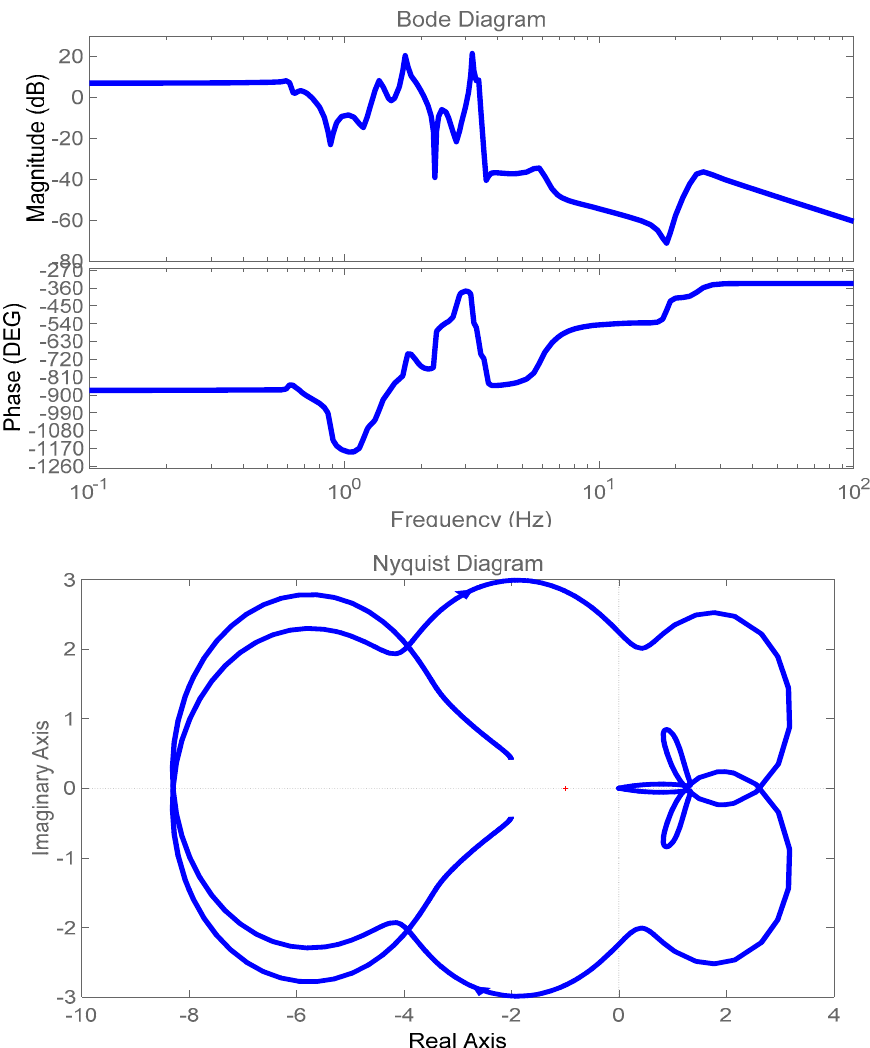
( s ) for the case ( ) 2 s Ω for the case ( 1,2 ) 1,2